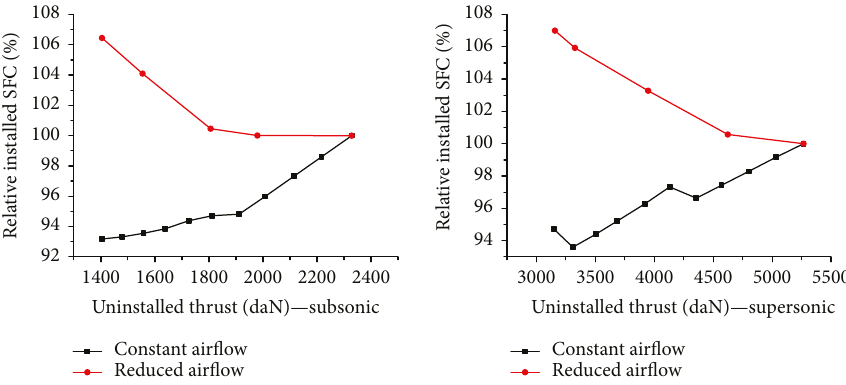
Figure 18: Variation of installed SFC during